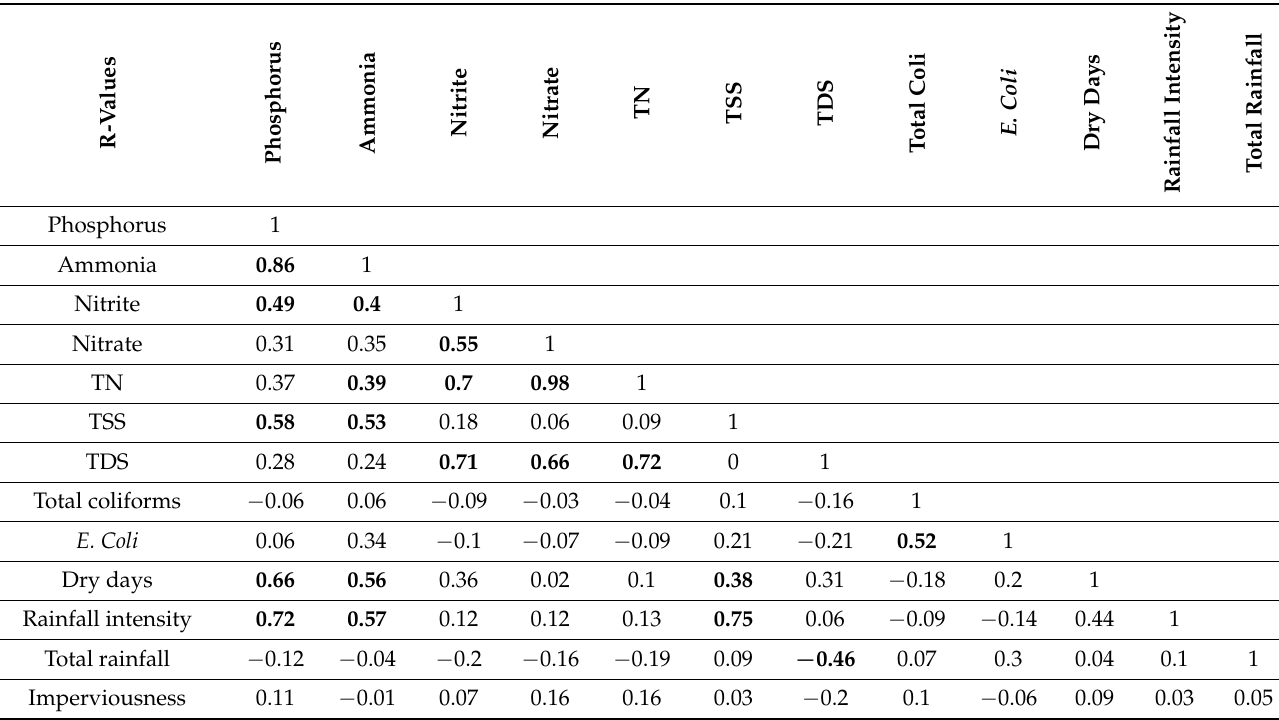
Table A1. Person’s Correlation R-values for wet weather water quality, excluding metals. Highlighted values are R-values that are statistically significant at the 5% significance